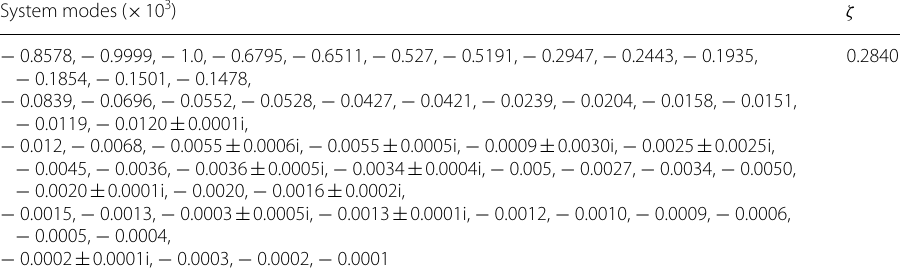
Table 7 Eigenvalues and minimum damping ratio (hDE-PS: FOPID; with HVDC